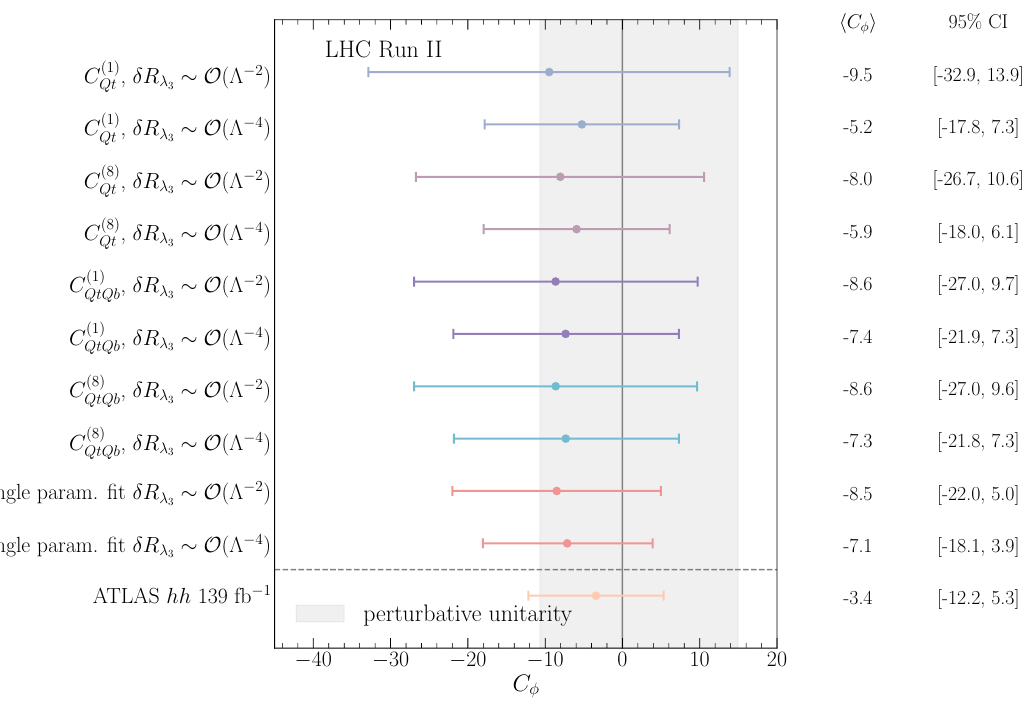
Figure 6 . A forest plot illustrating the means and 95% CIs of the posteriors for C φ from the two-parameter fits with the four-fermion operators marginalised. We compare the fit results for C φ from full Run-II Higgs data keeping terms up to O (1 / Λ 2 ) or O (1 / Λ 4 ) in δR λ also the 95% CI and means for the single parameter fit for C φ with the same single-Higgs data are shown, as well as the bounds on C φ from the 139 fb − 1 search for Higgs pair production [59]. The different four-fermion operators are assumed to be defined at Λ and hence the fits include both the finite and logarithmic corrections in table 1. The horizontal grey band illustrates the perturbative unitarity bound